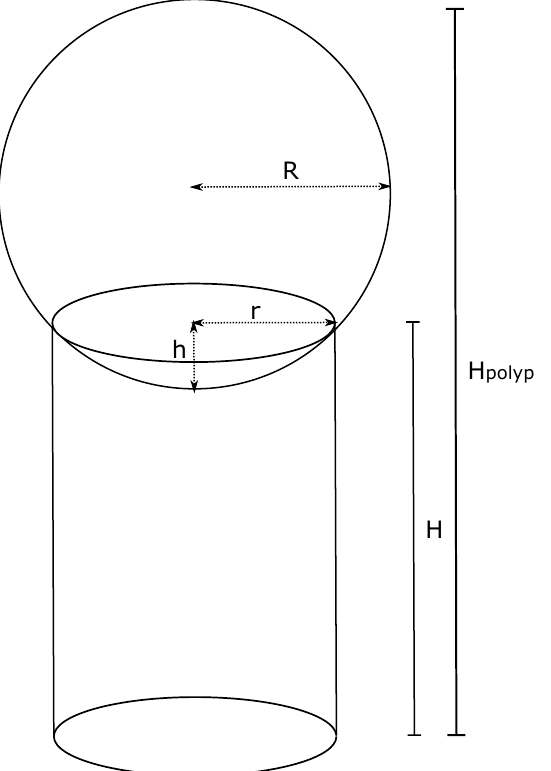
Figure 14. Simplified representation of a neoplastic polyp of the tubular adenoma